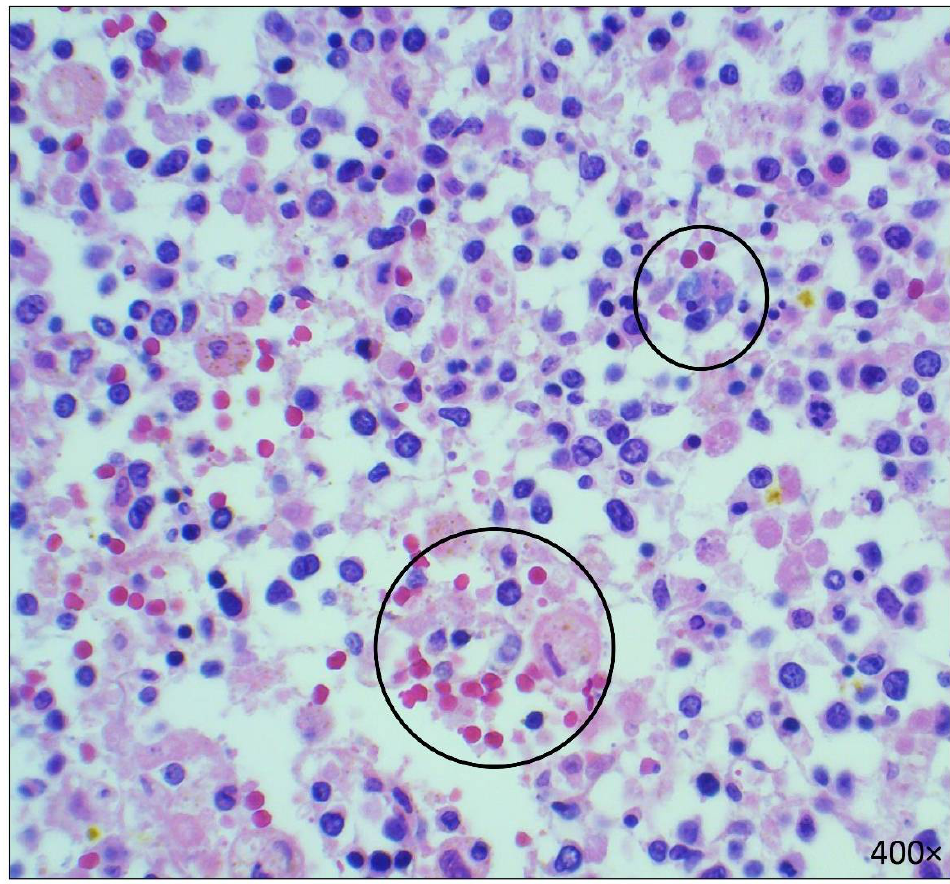
Figure 6. Microscopic images of the bone marrow showing hemophagocytosis, referred to with black circles (H&E, 400× magnification).